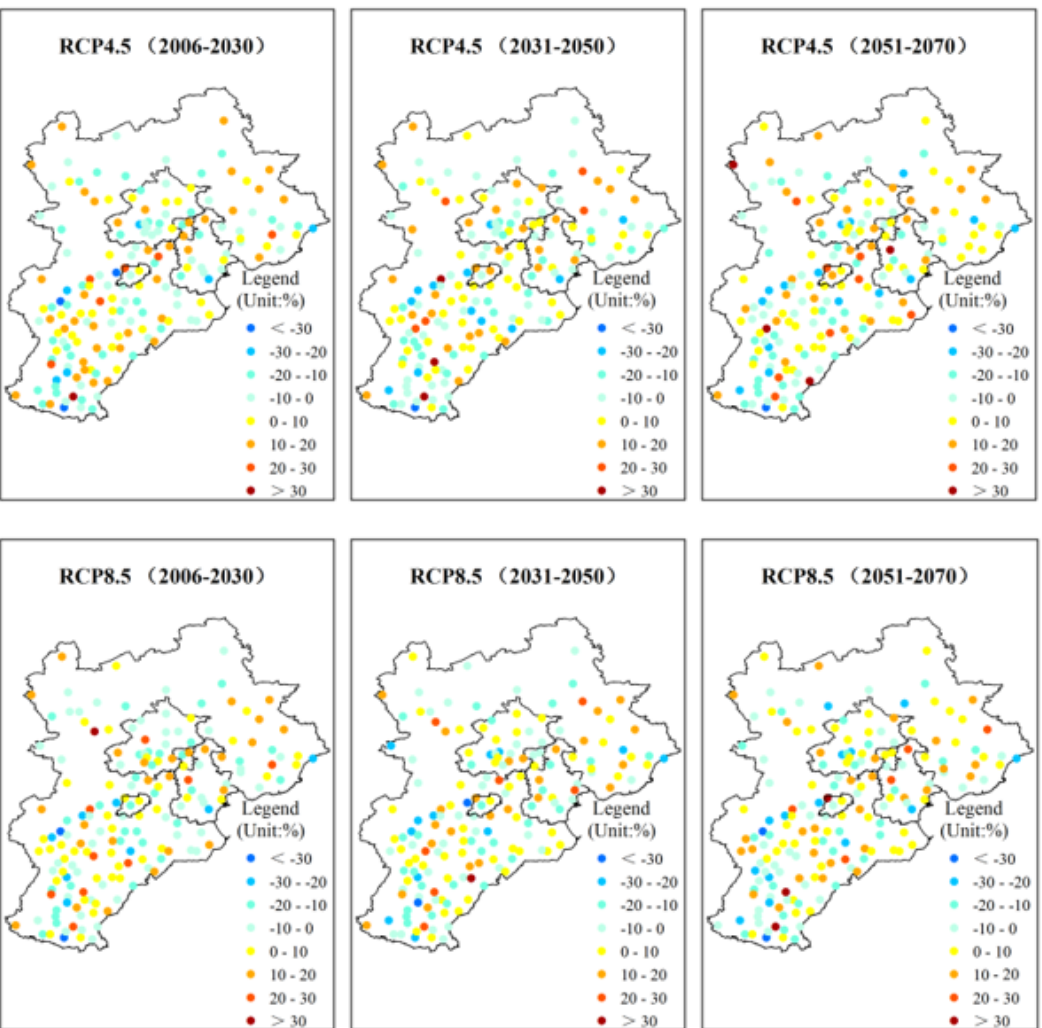
Figure 8. Spatial distribution of annual percentage changes of Pxcdd across the Beijing-Tianjin-Hebei region during 2006–2030, 2031–2050, and 2051–2070 compared with 1961 – 2005.